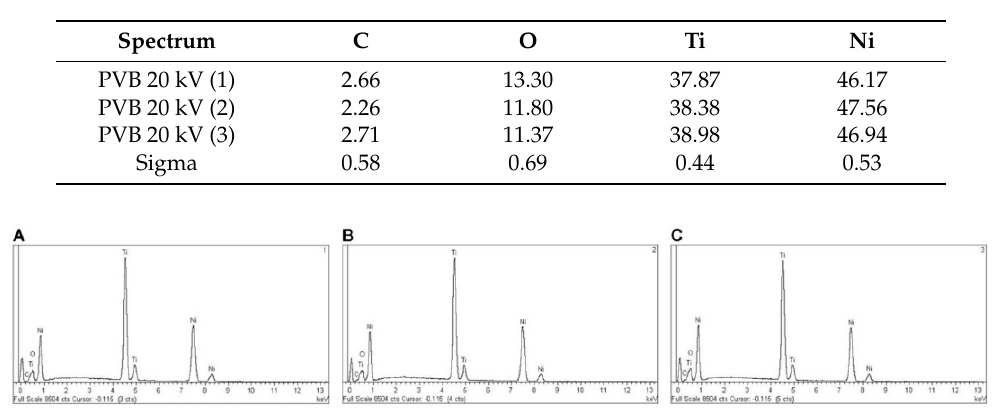
Figure 14. EDX micro-analysis of CM-Blue Wire PVB endodontic rotary files at locations ( A ) 1, ( B ) 2, and ( C ) 3.